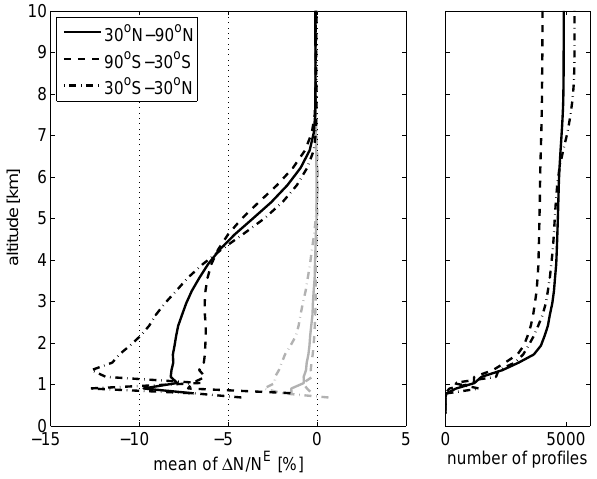
Fig. 7. Range deviation for 180 occultation events recorded on 7 August 2008. Left: excess range E NCO as a function of line-of-sight altitude. Right: excess range E as a function of line-of-sight altitude. The individual closed-loop (open-loop) data points are marked in light (dark) grey. Solid and dashed lines indicate the mean and 1- (cid:27) standard deviations for the two subsets (OL in red, CL in blue). 4 events with deviations exceeding 100 m are excluded from the statistics. (For details see text.)